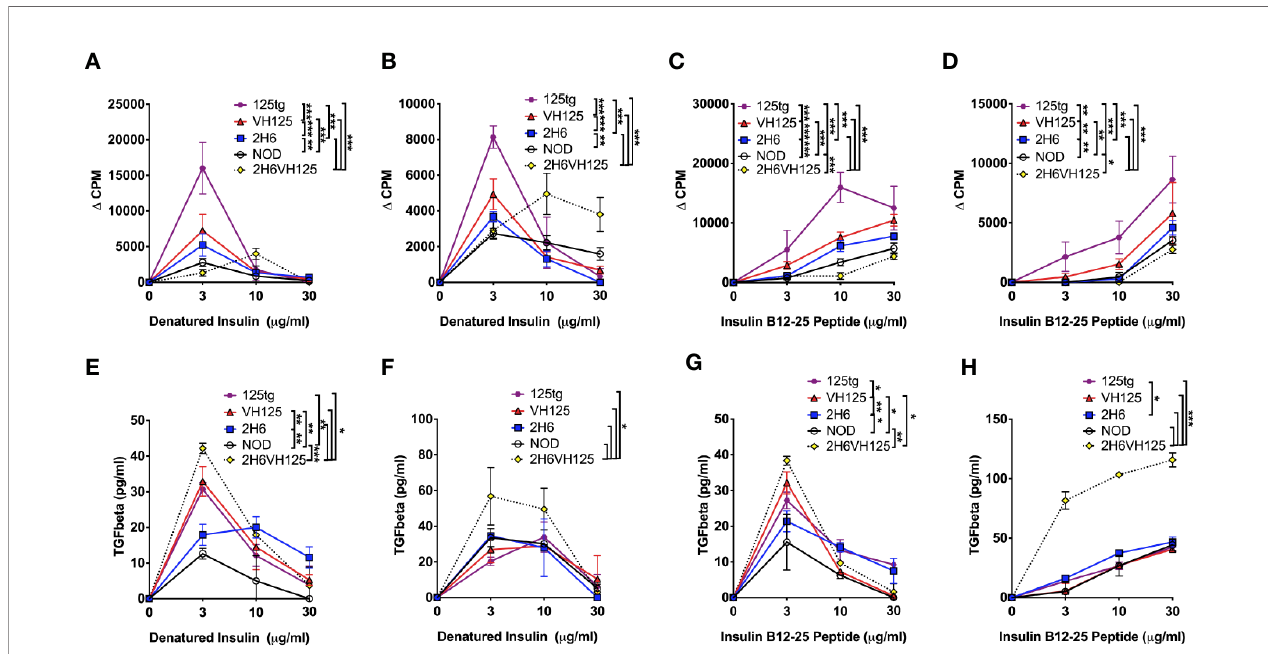
FIGURE 4 | 2H6 TCR transgene strongly reduces antigen presentation by insulin-reactive VH125 B cells and increases anti-in fl ammatory TGF b secretion. Splenic B cells were negatively isolated and cultured with bead-puri fi ed CD4+ T cells from 8-week-old mice in a 1:1 ratio. Cells were co-cultured with denatured insulin or insulin B chain 12-25 peptide at various concentrations for 48 h prior to supernatant collection and 3 H-thymidine addition. Proliferation was measured by 3 H- thymidine incorporation and plotted as D CPM, where the background CPM (cells without antigen) was subtracted from the CPM of cells with antigen. (A, B) 2H6 CD4+ T cells isolated from 2H6 NOD mice (A) or 2H6 T cells isolated from 2H6VH125 NOD mice (B) co-cultured with B cells from various donors and denatured insulin. (C, D) 2H6 CD4+ T cells isolated from 2H6 NOD mice (C) or 2H6 T cells isolated from 2H6VH125 NOD mice (D) co-cultured with B cells from various donors and insulin B chain 12 – 25 peptide. (E – H) TGF b measurements from the supernatants of the respective cultures in (A – D) . Data were generated from three independent experiments (n = 2 – 3 mice/experiment). Data from NOD mice are shown as a non-transgenic mouse comparison. Data were assessed for signi fi cance using two-way ANOVA. *P < 0.05, **P < 0.01, ***P <